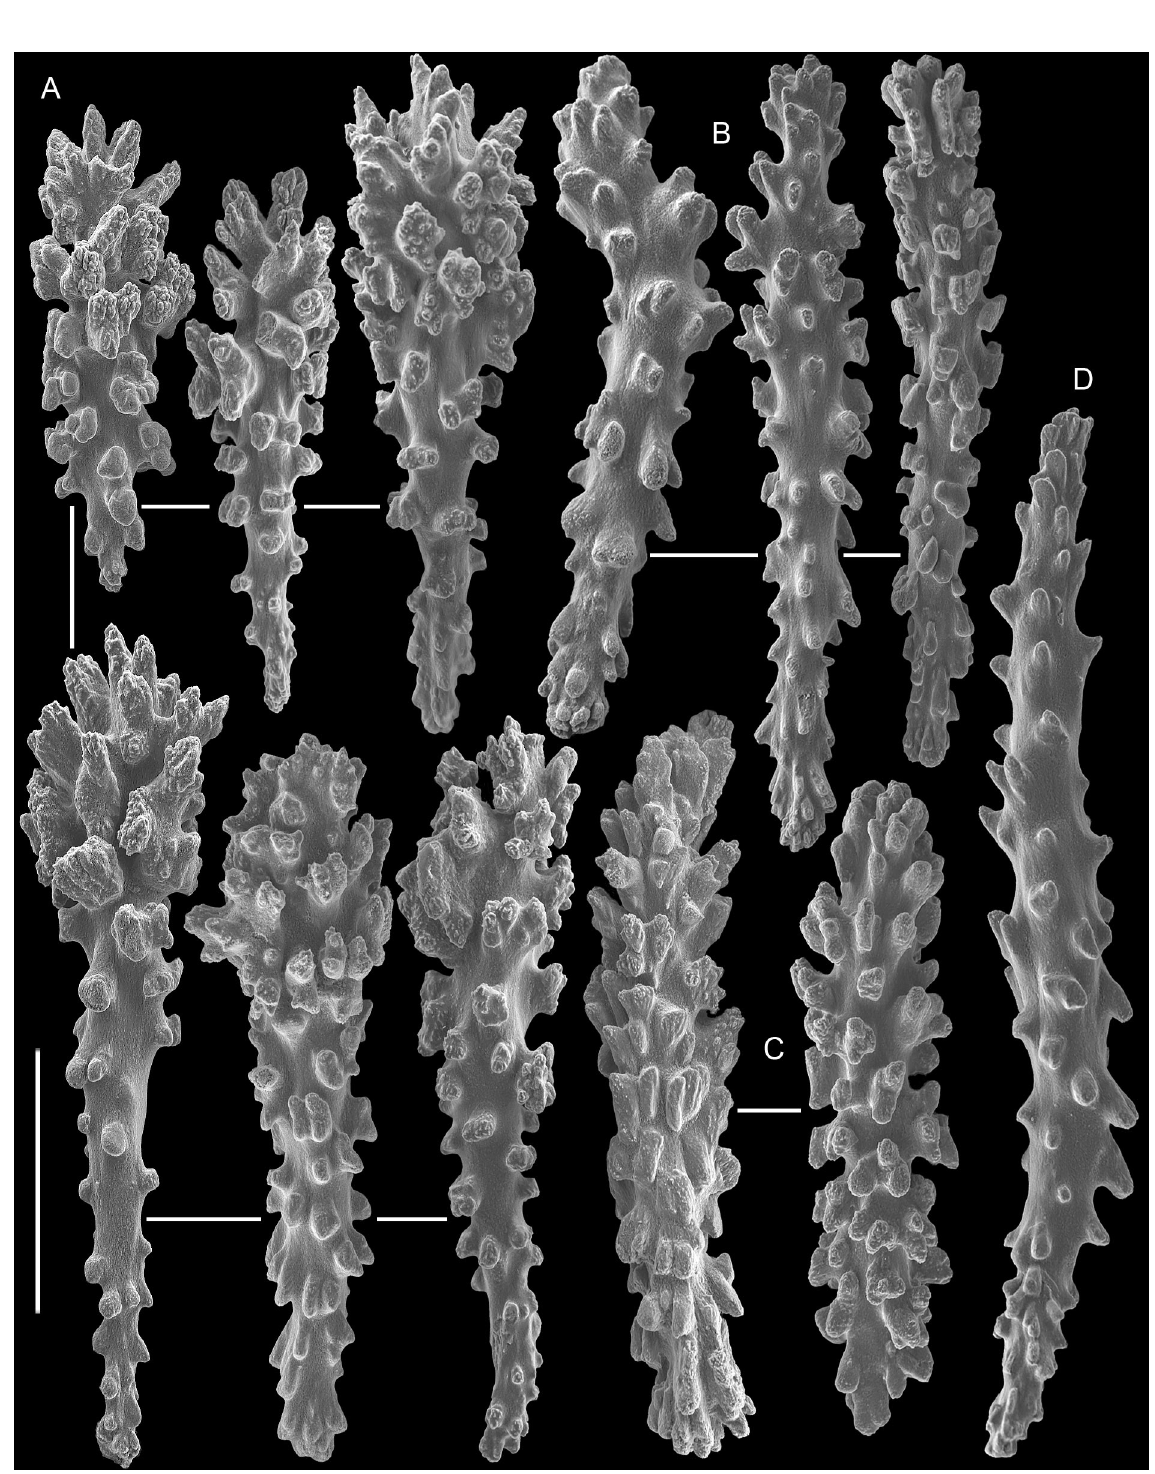
Fig. 11. Calcigorgia simushiri sp. nov., paratype (MIMB 20703), sclerites from the tentacles of polyp. A . Clubs. B . Club-like spindles. C . Spindles ornamented with conical hillocks inclined toward the spindle ends. D . Narrow tapered spindles ornamented with tubercles. Scale bar: 0.1